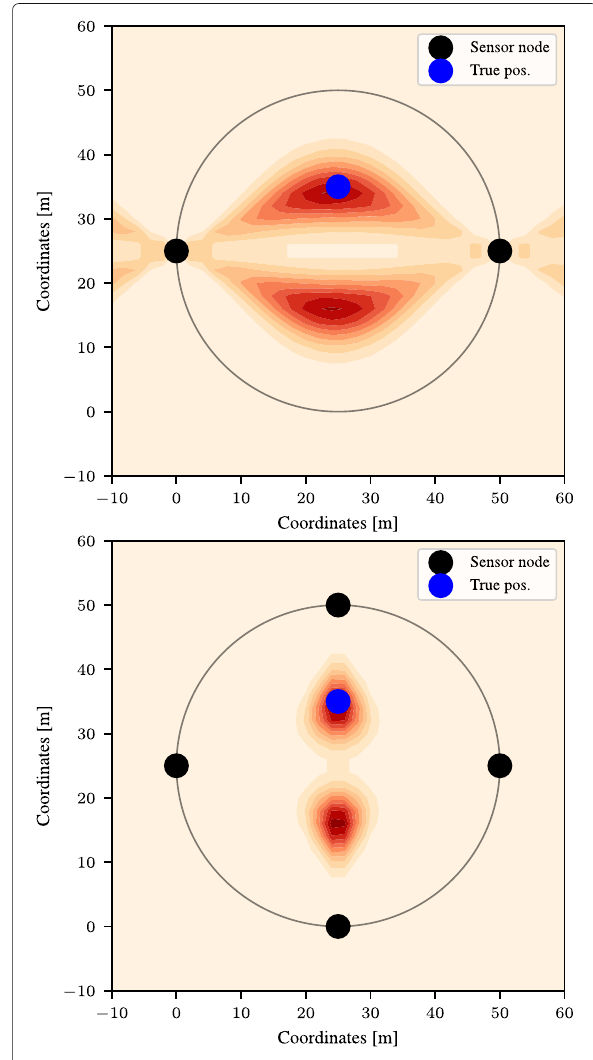
Fig. 14 Likelihoods for different number of nodes. All nodes are equidistantly placed on a circle as indicated in the figure. True position of the tracked object is at [25,35]. a Ambiguous bearing: 2 nodes. b Ambiguous bearing: 4